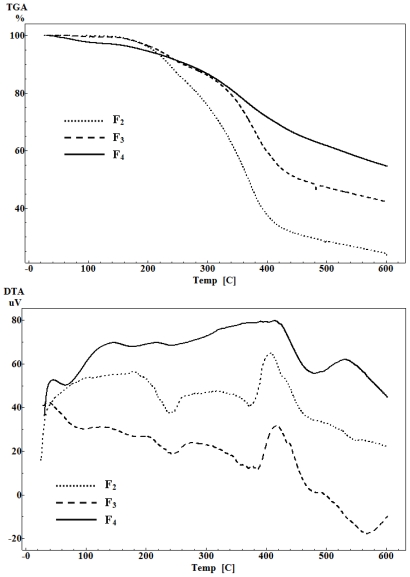
TGA/DTA curves of lignin fractions F2, F3 and F4.